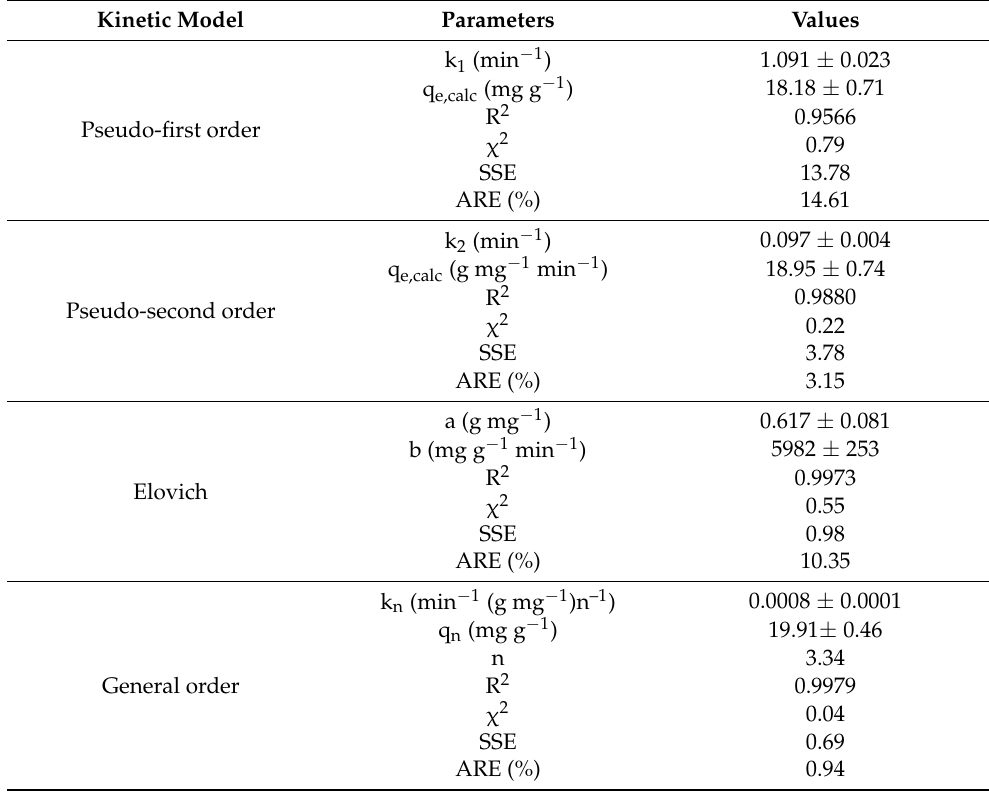
Table 3. The tested kinetic models’ constants and the corresponding statistical parameters. Kinetic Model